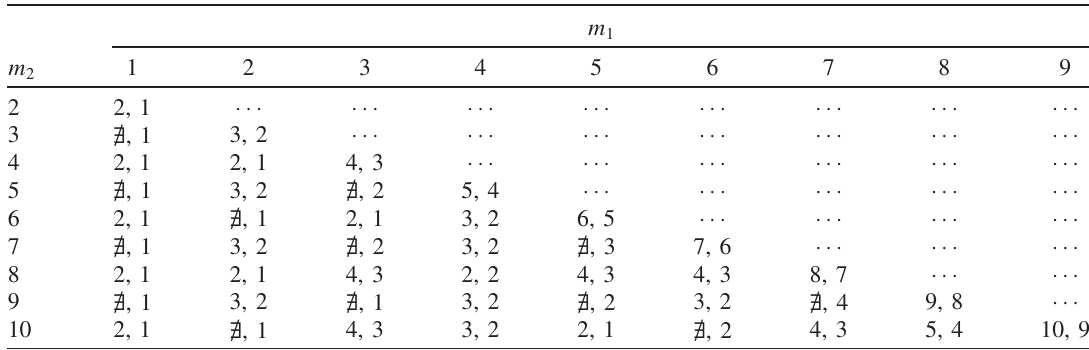
mode shown for the case ϕ f m 1 ;m 2 g η 0 ∄ denotes a spiral